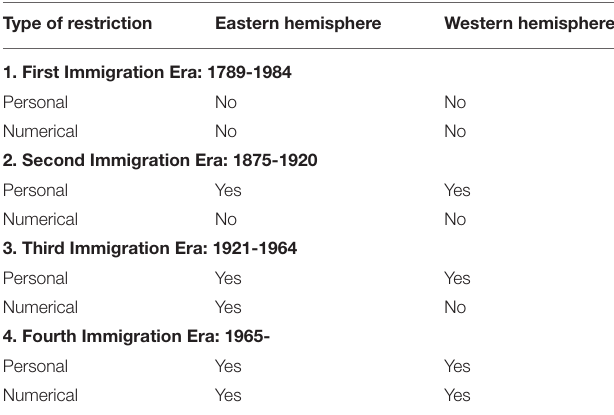
TABLE 3 | Four immigration eras in the United States, classified by type of migration restriction and